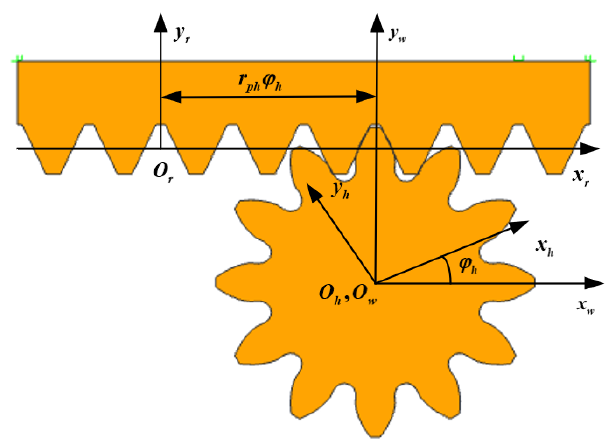
Figure 2. Schematic diagram of honing tool with rack tool.